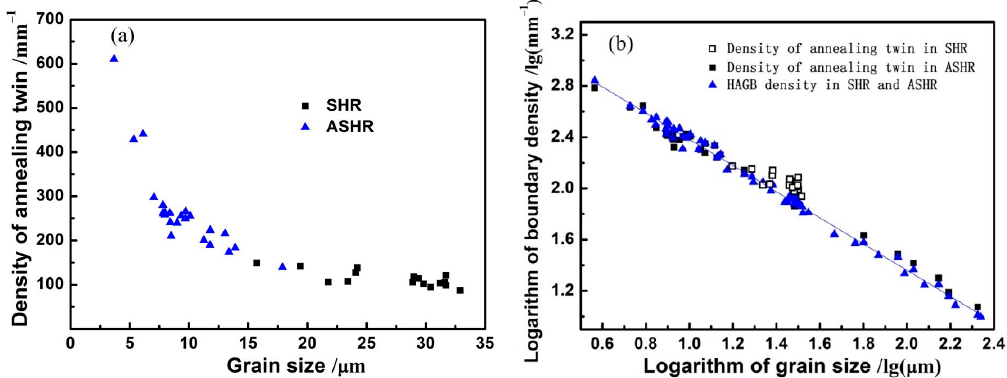
Figure 4. Variation of density of annealing twin boundaries ( a ) as a function of average grain size, logarithm of the boundary density as a function of logarithm of the grain size ( b ) in SHR and ASHR process.